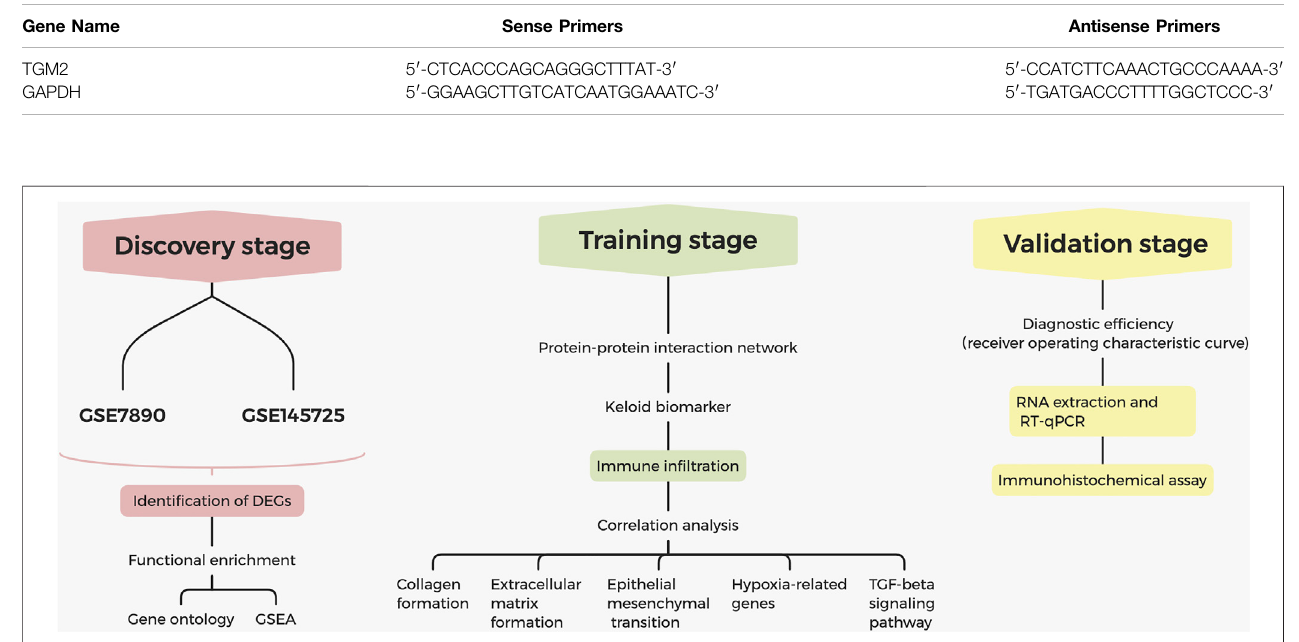
TABLE 2 | Primers and their sequences for Quantitative RT-PCR analysis.